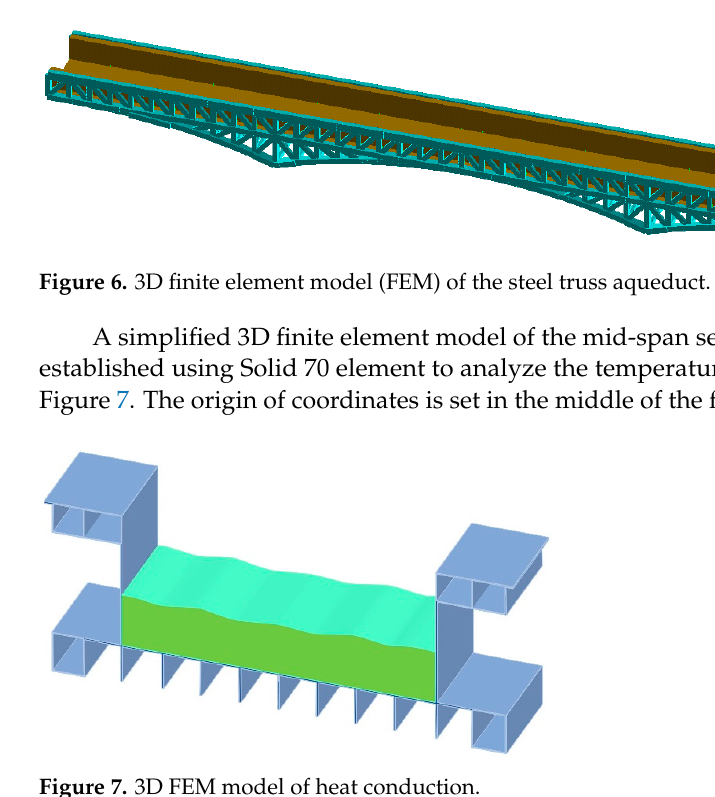
Figure 7. 3D FEM model of heat conduction.